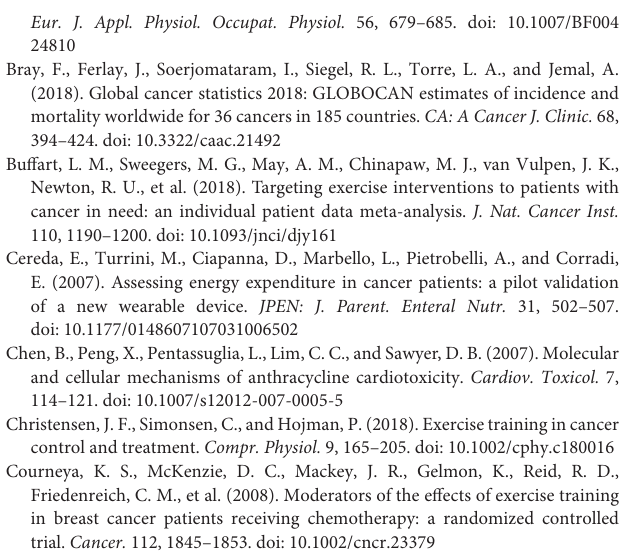
Supplementary Figure S1 | Adherence to the endurance training for participants < and > 61 years, and within the two exercise intensities. LMI, low-to-moderate intensity; HI, high intensity; ∗ = p < 0.01. Means in % with 95% confidence interval. Supplementary Table S1 | General linear model regression including the eight models. All the seven models were adjusted for baseline VO 2 peak and hospital was included as a